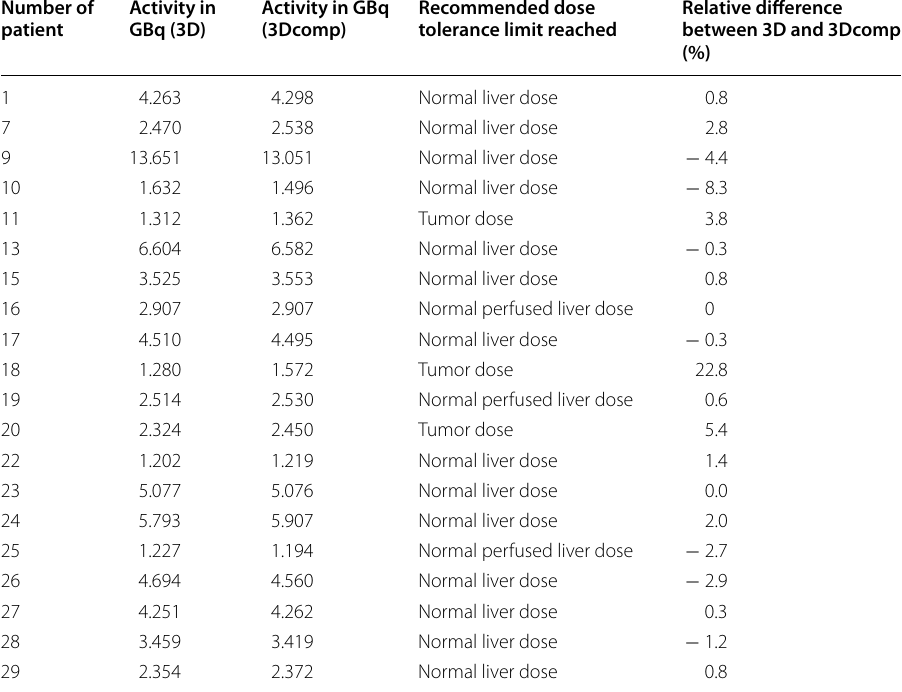
Table 3 Activities to be prescribed for each patient and each reconstruction (3D and 3Dcomp) estimated from international recommendations [10,